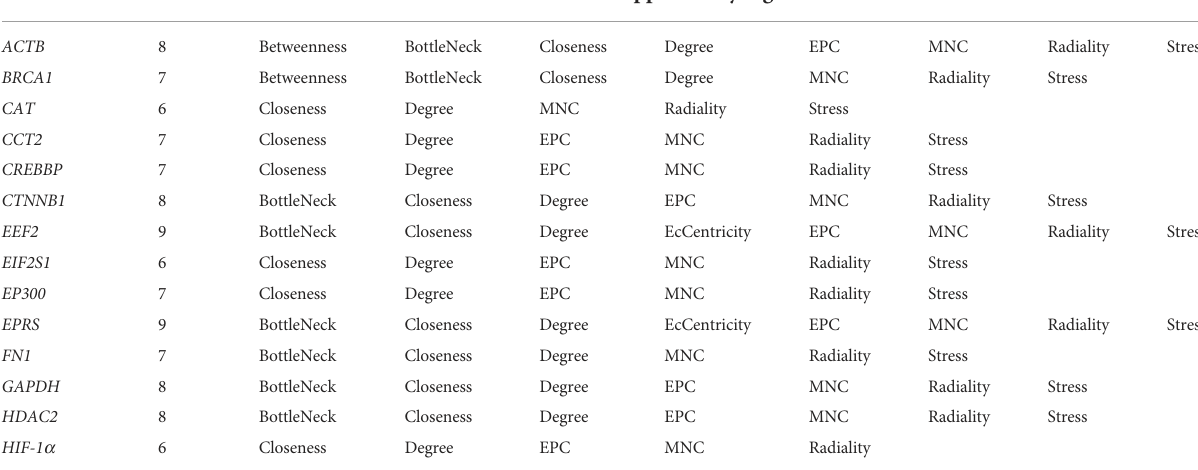
TABLE 1 Identi fi cation of hub genes through Cytohub plug-in with 12 algorithms. Gene